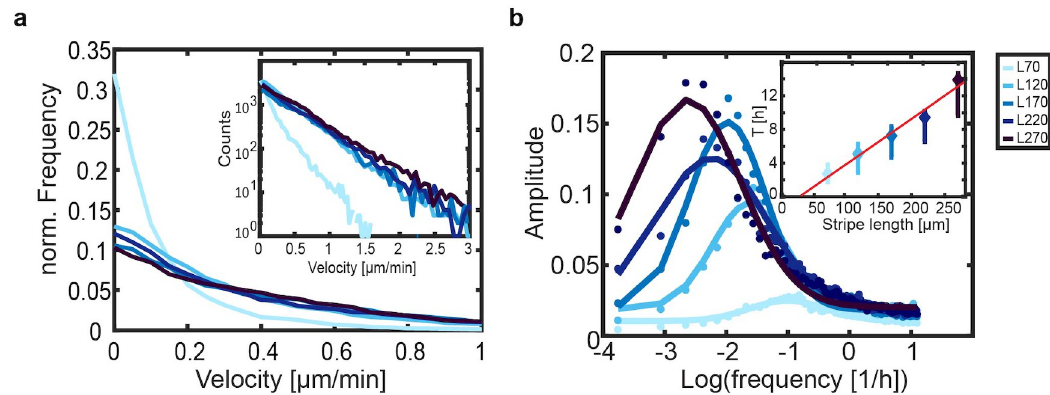
Fig 3. Overall spectral analysis of the large ensemble of cell traces. ( a ) Normalized distribution of absolute cell velocities, h | v | i , for single MDA-MB-231 cells migrating in stripe-shaped micro patterns of five different lengths and fixed width (W = 20 μ m). Inset: Non-normalized (counts) velocity distribution in a logarithmic plot. ( b ) Discrete Fourier transform of the time-dependent directional velocities, averaged over the cell ensemble, fitted by a log-normal distribution (lines). Inset: The migration period (T = 1/ frequency) of single cells increases linearly with the stripe length. The error bars correspond to the peak width of the fitting in ( b ).